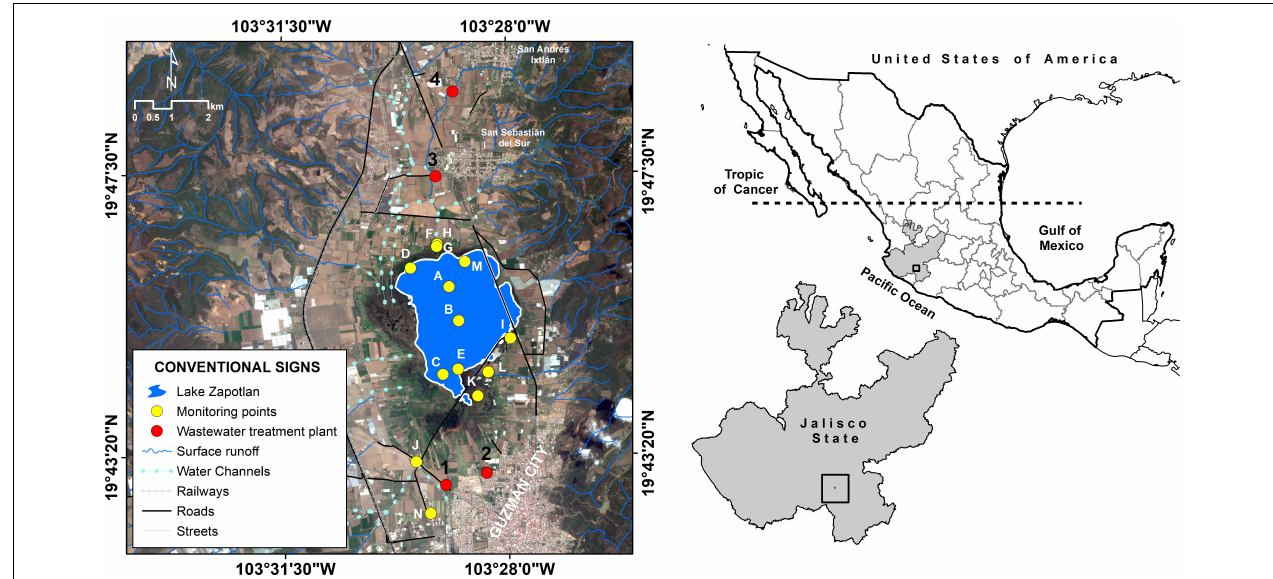
FIGURE 1 | Location of the sampling stations in Lake